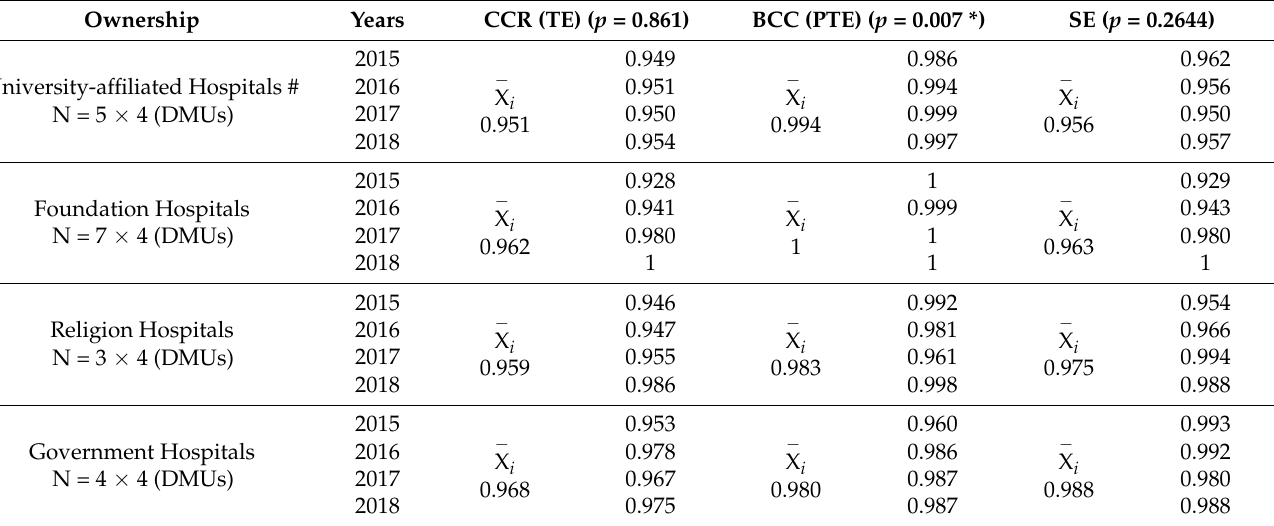
Table 6. The DEA average efficiency value with different categories of